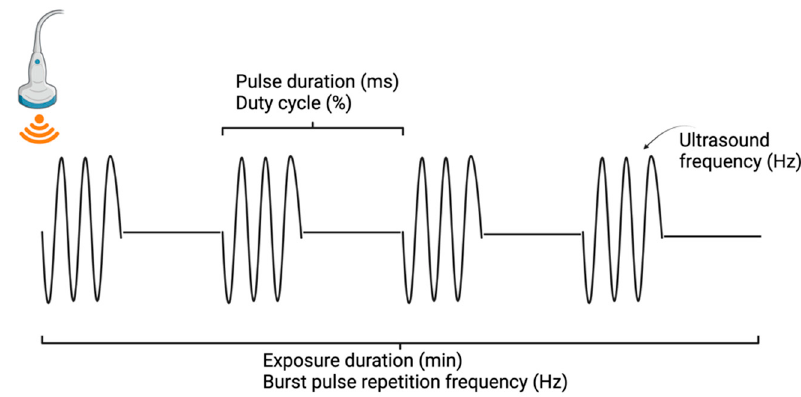
Figure 1. Depiction of ultrasound parameters. Created with BioRender.com.